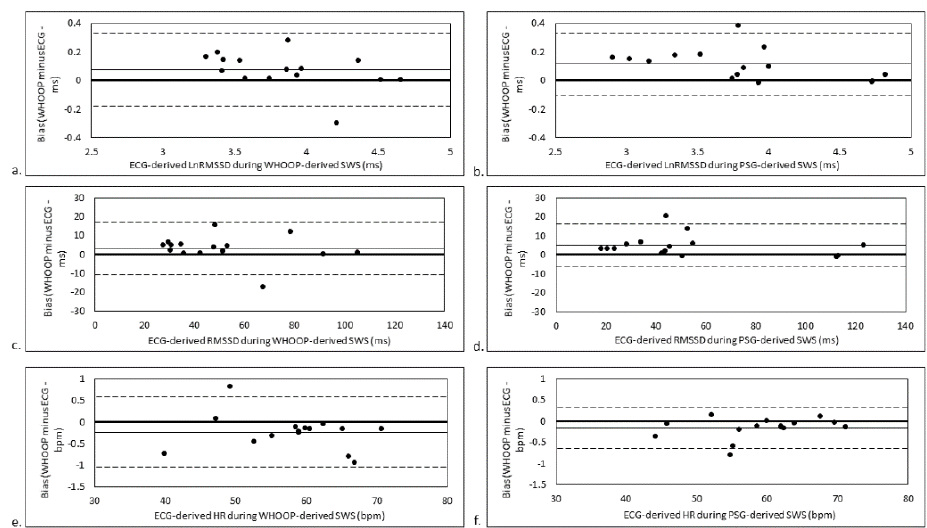
Figure 1. Agreement between ( a ) ECG-derived Ln RMSSD and WHOOP-derived Ln RMSSD during WHOOP-derived SWS, ( b ) ECG-derived Ln RMSSD and WHOOP-derived Ln RMSSD during PSG-derived SWS, ( c ) ECG-derived RMSSD and WHOOP-derived RMSSD during WHOOP-derived SWS, ( d ) ECG-derived RMSSD and WHOOP-derived RMSSD during PSG-derived SWS, ( e ) ECG-derived HR and WHOOP-derived HR during WHOOP-derived SWS and ( f ) ECG-derived HR and WHOOP-derived HR during PSG-derived SWS. Thin continuous line represents mean bias. Dashed lines represent mean bias ± limits of agreement. bpm, beats per minute; ECG, electrocardiogram; HR, heart rate; Ln RMSSD, natural logarithm of the root mean square of successive BB interval differences; ms, milliseconds; PSG, polysomnography; RMSSD, root mean square of successive BB interval differences; SWS, slow-wave sleep.